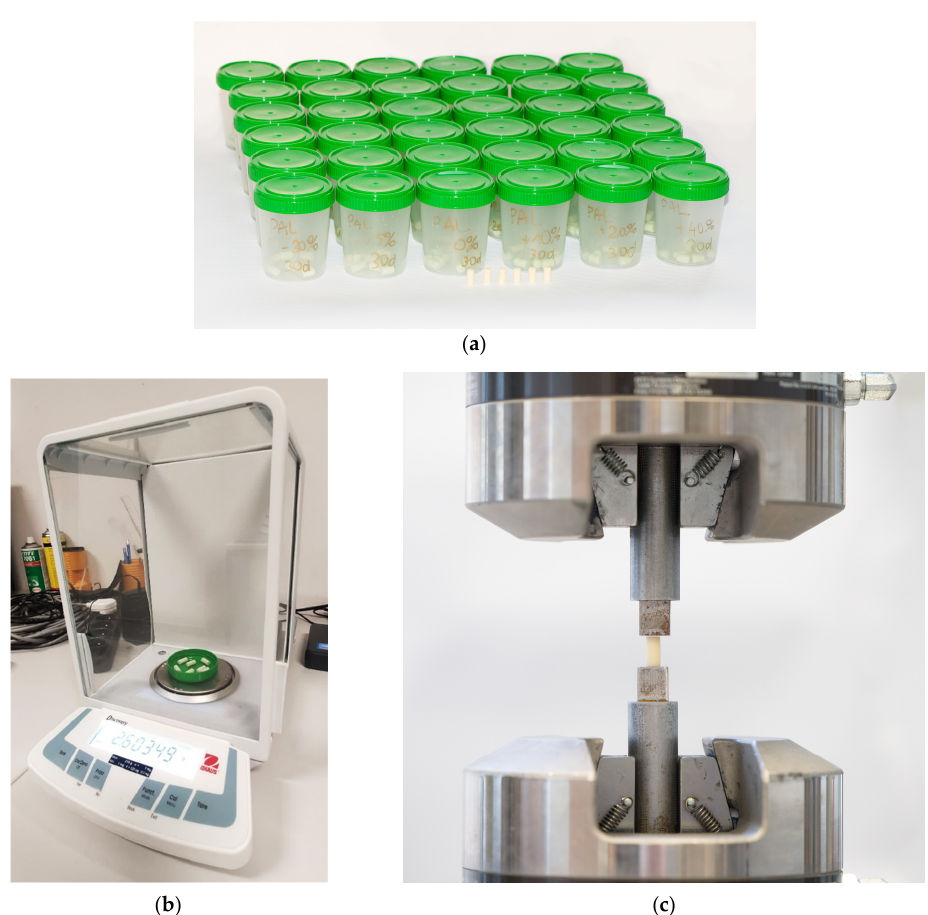
Figure 2. ( a ) Seasoned samples—PALAMED series, ( b ) weighing of seasoned samples and ( c ) specimen ready to be compressed, fixed in holders.